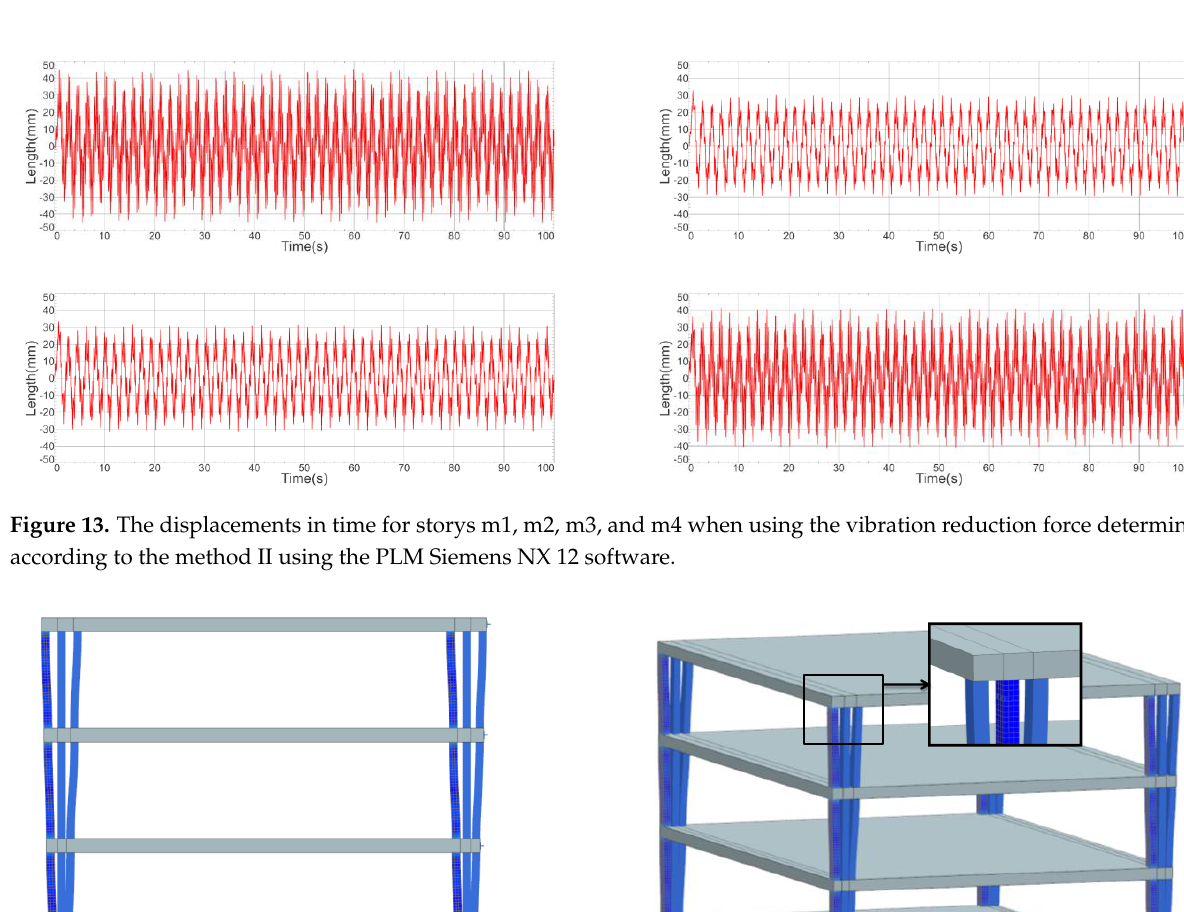
determined in accordance with method I using the PLM Siemens NX 12 software.